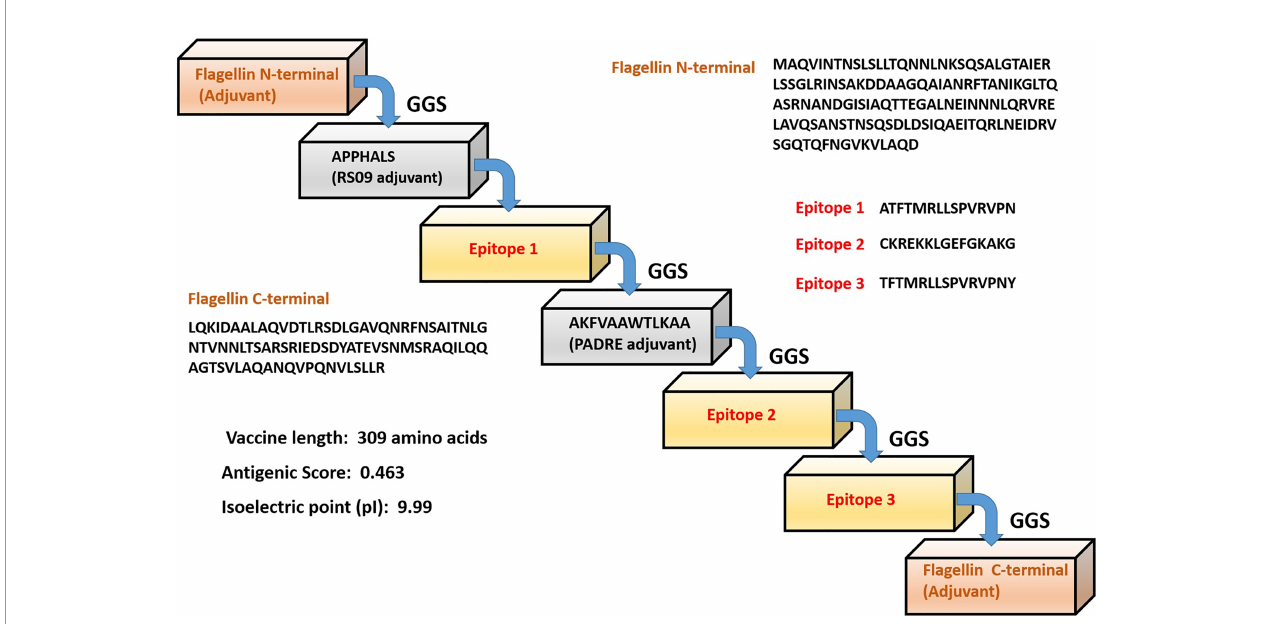
FIGURE 1 | Schematic representation of the predicted multi-epitope vaccine construct with different adjuvants, linkers and epitopes with their respective amino acid